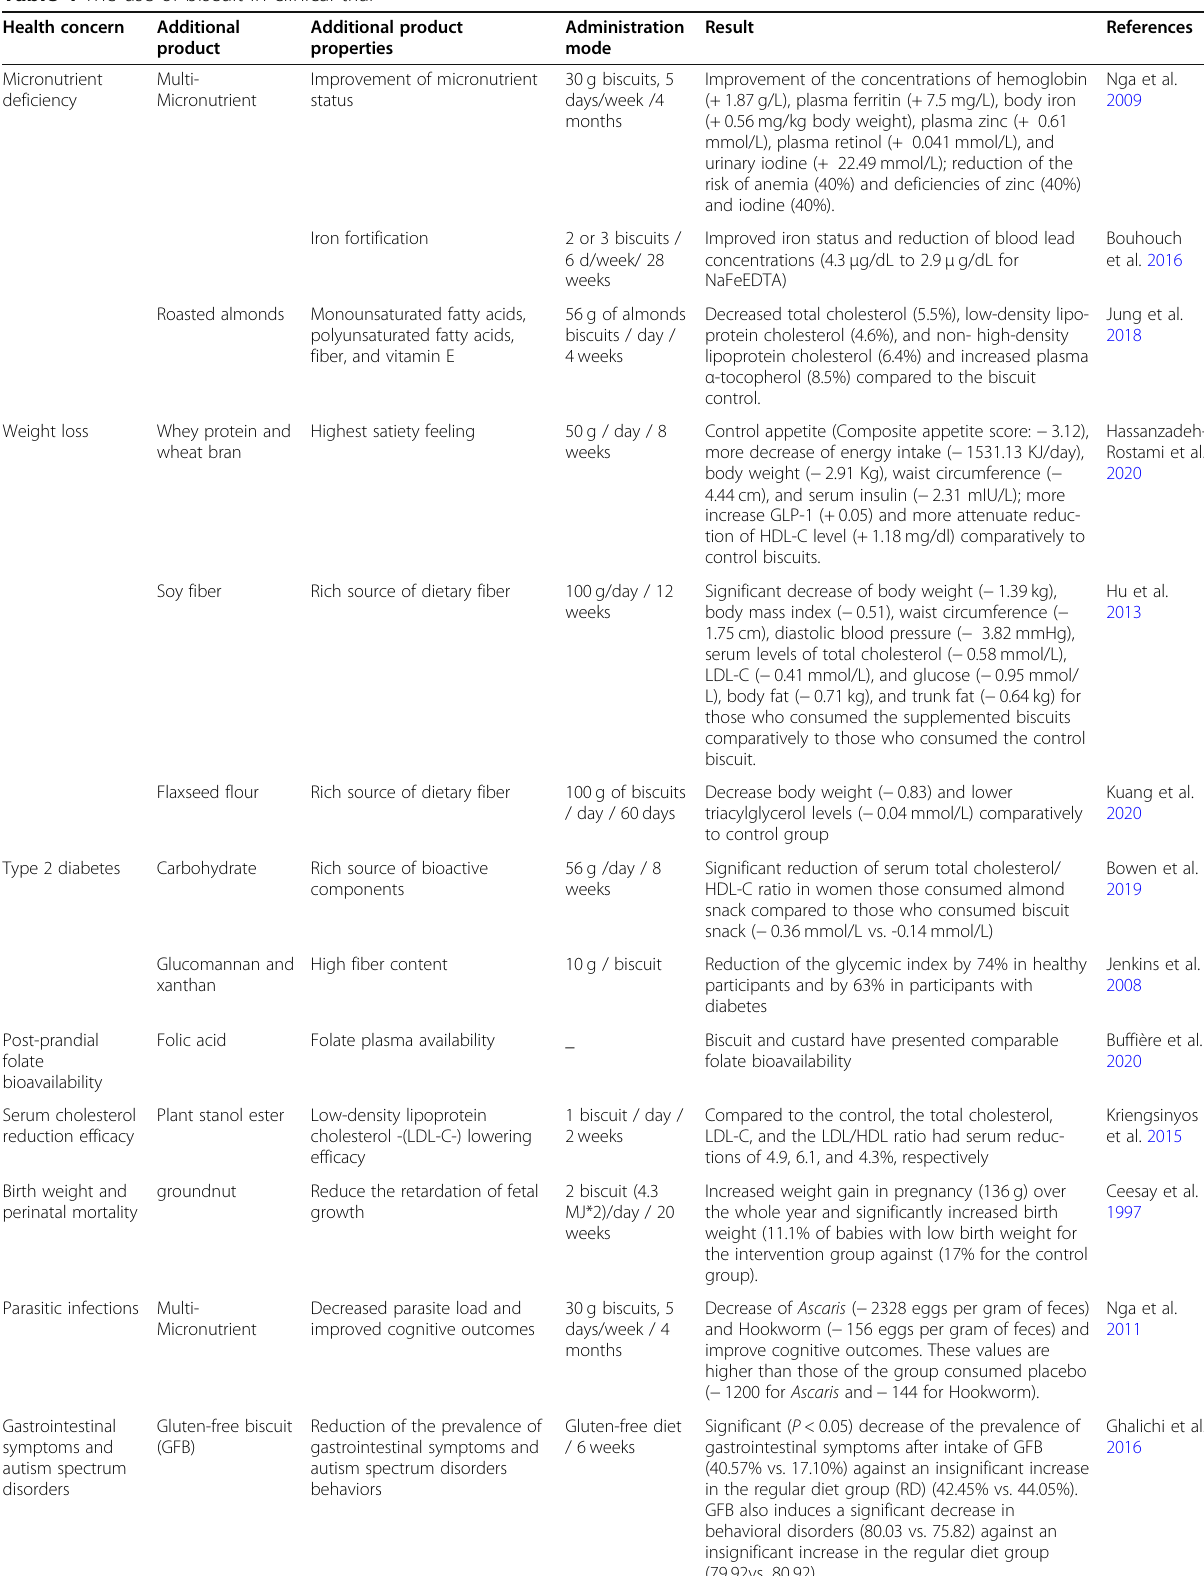
Table 4 The use of biscuit in clinical